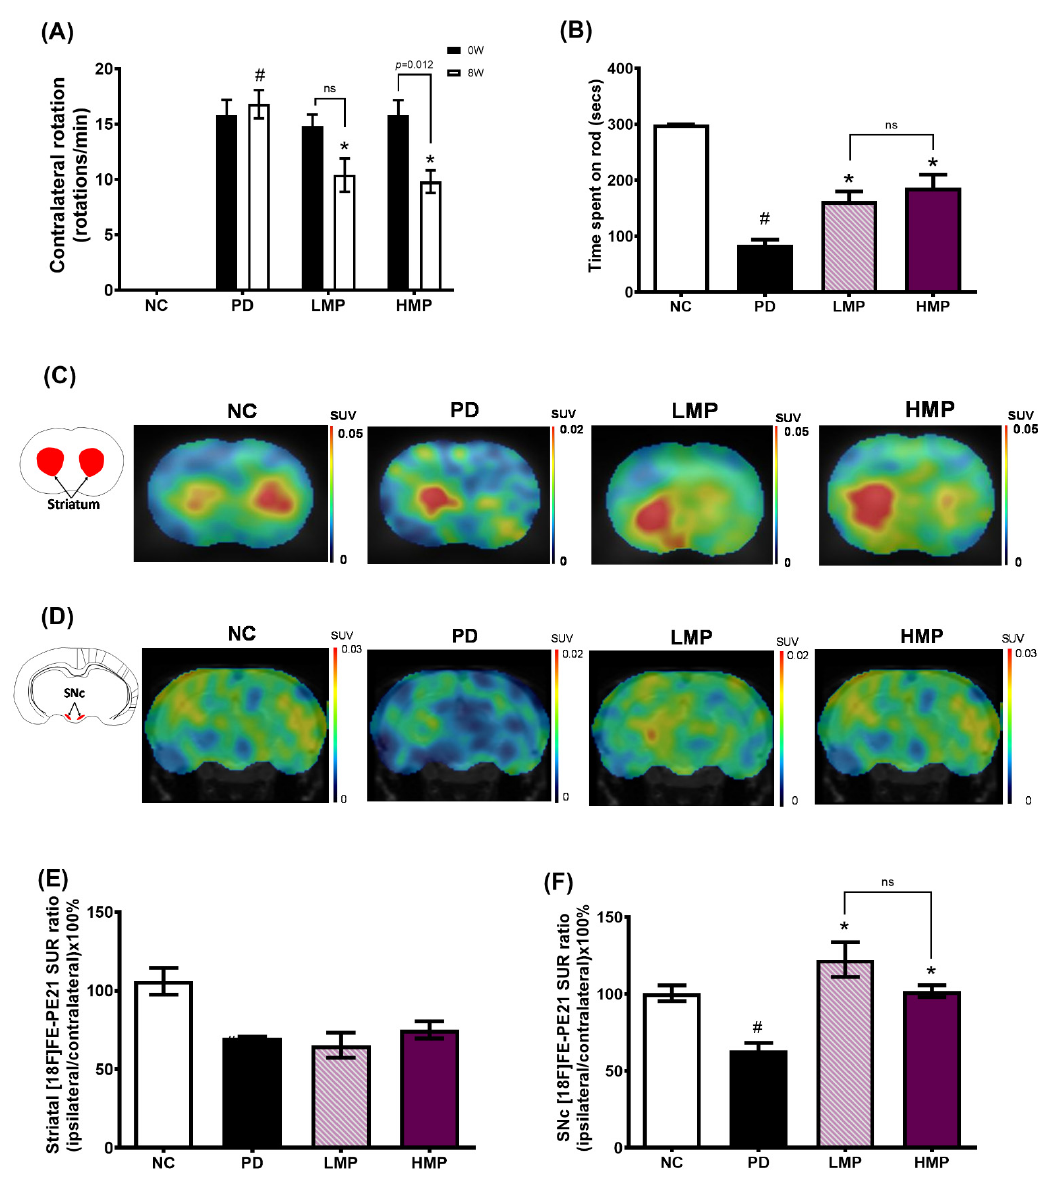
Figure 2. Effects of mangosteen pericarp (MP) extract supplementation on motor function. ( A ) Num- ber of contralateral rotations recorded in the apomorphine-induced rotation test at week 0 and week 8 of supplementation. ( B ) Evaluation of motor coordination and balance skills in the rotarod test after 8 weeks of supplementation. ( C ) Representative images of the standard uptake ratio (SUR) of [ 18 F]FE-PE21 in the striatum, illustrating the dopamine transporter (DAT) binding activity. ( D ) Representative images of the SUR of [ 18 F]FE-PE21 in the substantia nigra pars compacta (SNc). ( E ) Quantitation of the SUR ratio in the striatum. ( F ) Quantitation of the SUR ratio in the SNc. Data are aver- age ± SEM for n = 5 rats/group and were compared using one-way ANOVA with Tukey’s post hoc test; # p < 0.05 for Parkinson’s disease (PD) group vs. normal control (NC) group. * p < 0.05 for low- dose mangosteen pericarp (LMP) and high-dose mangosteen pericarp (HMP) groups vs. PD group. ns, not significant.